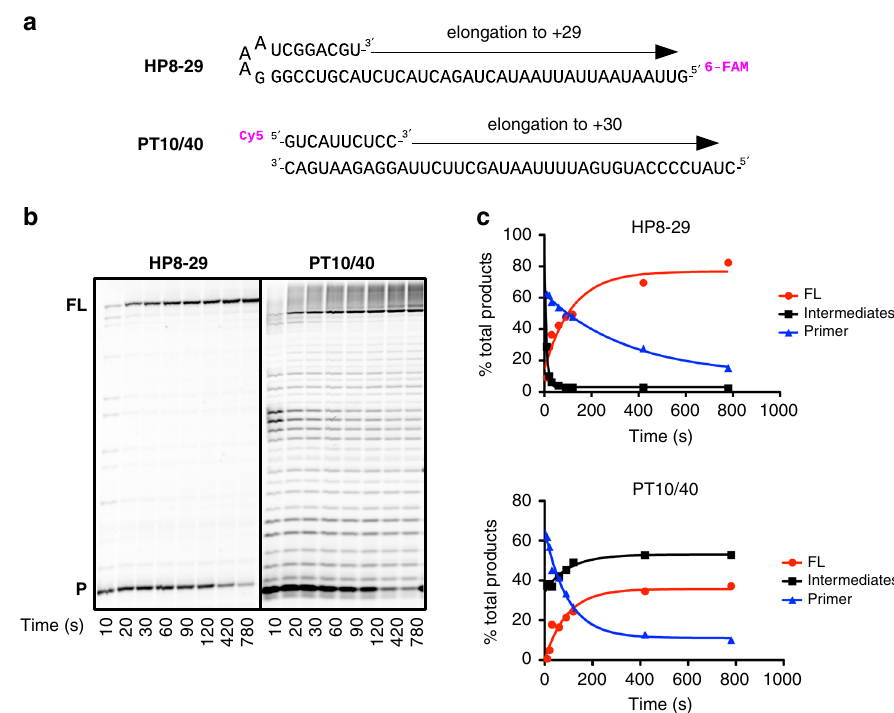
Fig. 2 Polymerisation modes of SARS-CoV nsp12. a, b Steady-state data showing extension of hairpin (HP) and annealed primer-template (PT) RNA substrates by the nsp12:7L8:8 complex. c Fraction of primer (P, blue), intermediate (black) and full-length (FL, red) species over time, as analysed from gel shown in panel b . Additional extension products beyond the full-length observed on the PT substrate are attributed to partially-denatured forms of the full- length product and were included in the analysis of the FL fraction. Source data are provided as a Source Data fi For the nsp12 complex, omission of ATP and/or GTP from attributable to the higher lability of this compound. Neither elongation reactions results in rapid incorporation of T-705 and T-1105 at multiple sites with both substrates (Fig. 3b, c). In clearly showing they function as purine analogues (Supplemen- reactions with 10 µM T-1105-RTP, multiple incorporation events tary Fig. 5). For the more processive HP complex, ef fi cient are seen within 10 s, while T-705-RTP is less ef fi cient, potentially